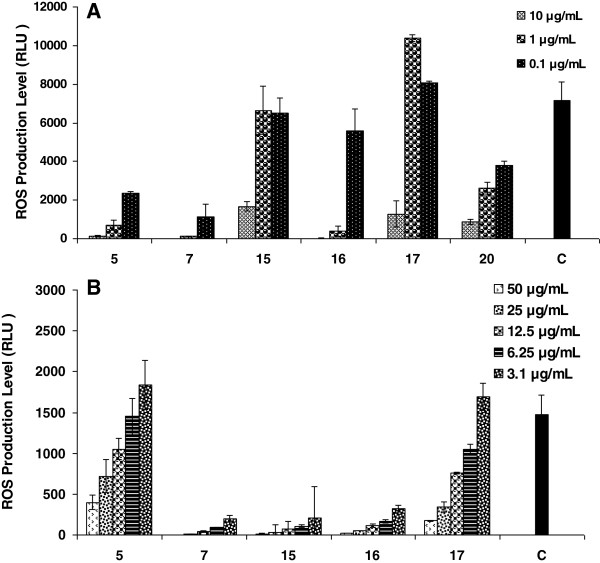
The Immunomodulatory effects of quinolone derivatives on oxidative burst response using isolated neutrophils (A) and mouse peritoneal macrophages (B). Each bar represents a mean of triplicate reading after 30-minute incubation and then serum opsonized zymosan activation. The solid bar [black] represents the activated control group cells [Neutrophiles/Macrophages].